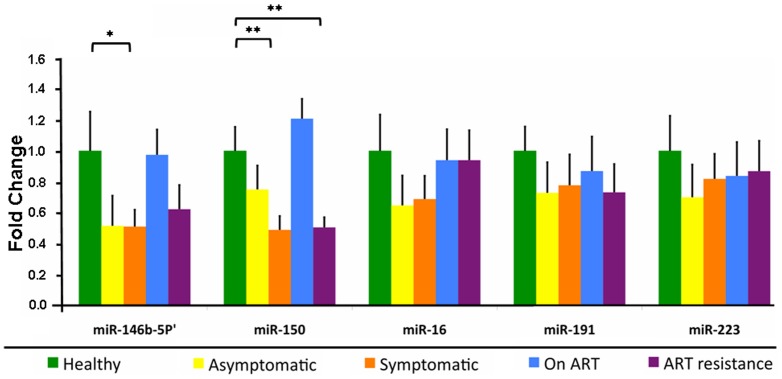
Differential expression of the indicated miRNAs in the PBMCs of healthy controls and HIV/AIDS patients at different stages of disease.The values in the bar graphs are given as mean ± SEM, and asterisks denote statistically significant differences (** p<0.01, * p<0.05) for the indicated groups (Student's T test).